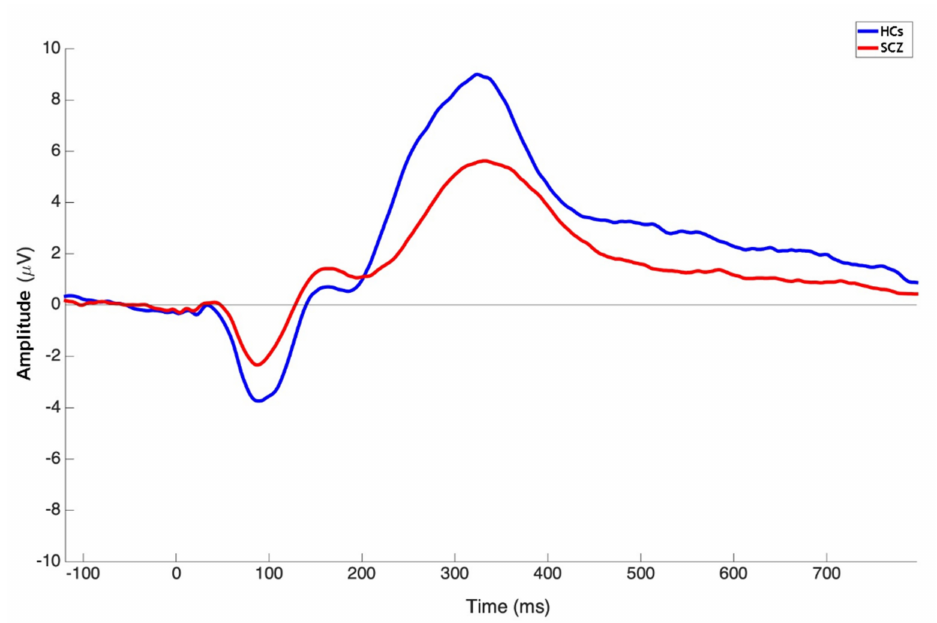
Figure 1. Grand average ERP waveforms of subjects with schizophrenia (red line) and healthy controls (blue line) from the Pz electrode.